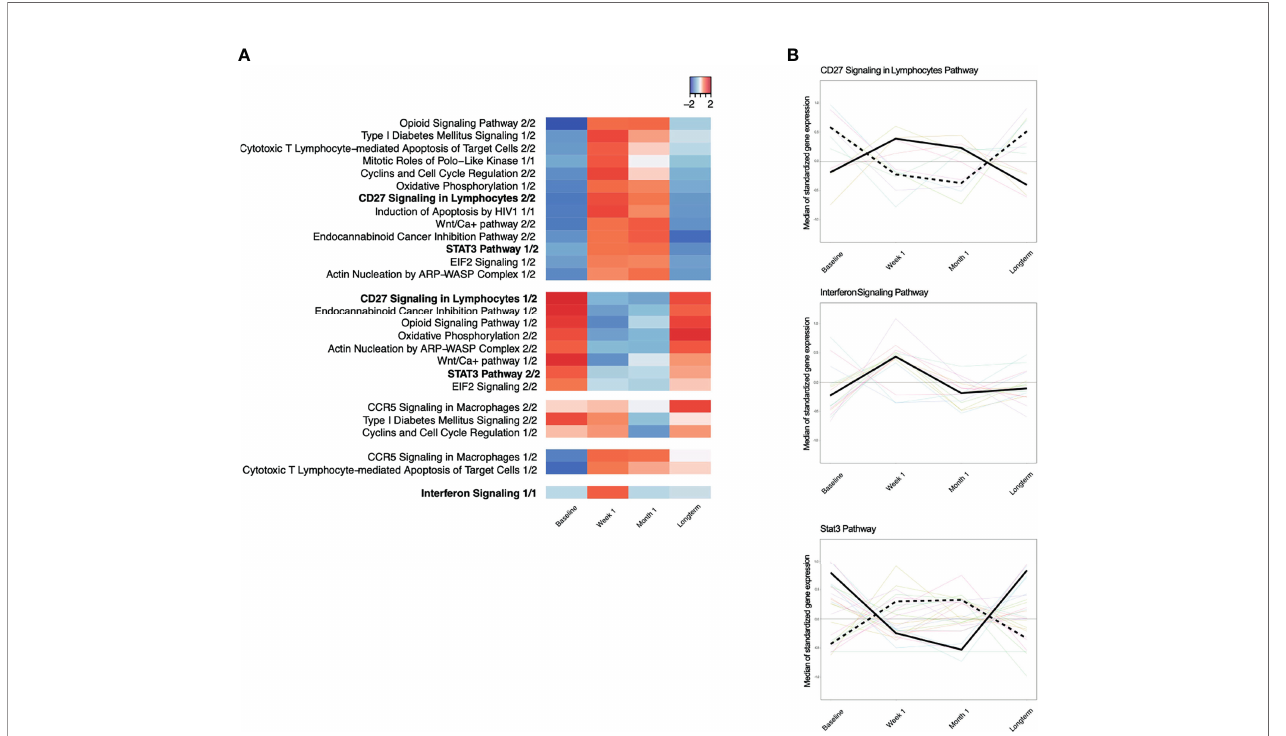
FIGURE 4 | (A) Time-course dynamics of IPA canonical pathways signi fi cantly enriched for with genes that were differentially expressed between baseline and week 1 post-viremia. Red indicates that the median of standardized gene expression of genes in a pathway are >0, while blue indicates that the median of standardized gene expression of genes in a pathway are <0. Each column represents a different time point, namely, baseline, week 1, month 1, and long-term. Most pathways have two signi fi cant time-trend as identi fi ed by time-course gene set analysis because some genes in a given pathway have a positive median standardized gene expression, while the other genes in the same pathway have a negative median standardized gene expression. (B) Examples of signi fi cantly enriched IPA pathways with two time trends, CD27 Signaling in Lymphocytes Pathway and Stat3 Pathway. Interferon Signaling Pathway has only one time trend.